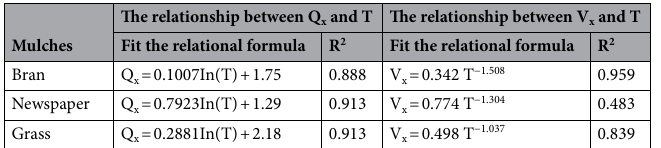
The relationship between Q x and T The relationship between V x and T Mulches Fit the relational formula R 2 Fit the relational formula R 2